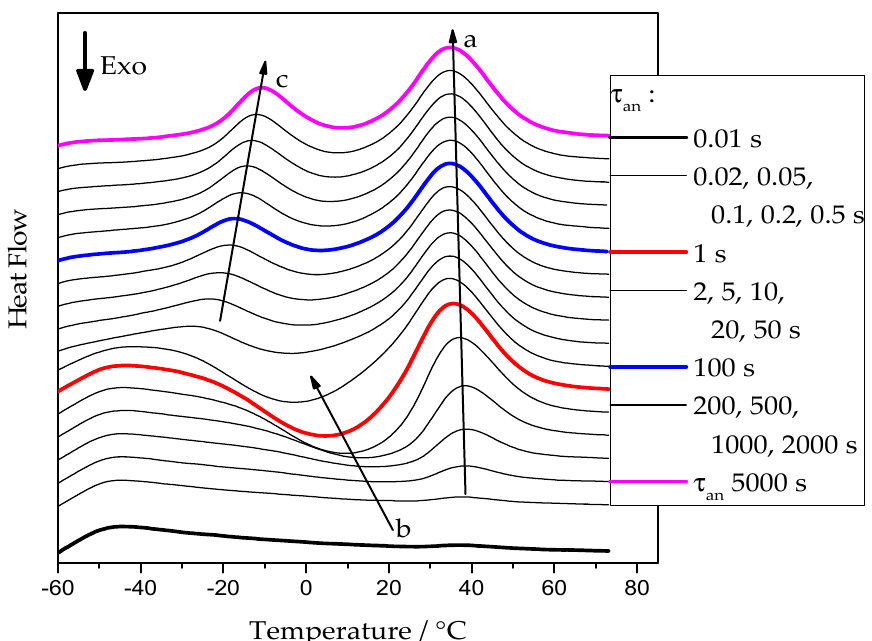
Figure 2. FSC heating curves of pure PCL at 5000 K/s after annealing at − 50 °C for various times. Arrows: a—development of the melting peak of the PCL re-crystallized on heating; b—development of the cold-crystallization exotherm; c—development of the melting peak of the tiny polymer crystals grown at the annealing temperature.